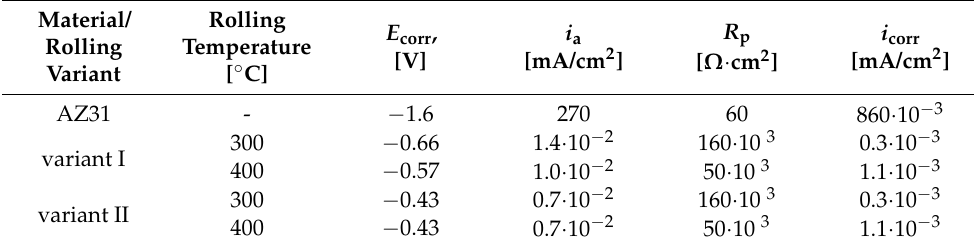
Table 4. Parameters determining the corrosion resistance of the initial materials and the Mg/Al bimetal after various rolling variants.